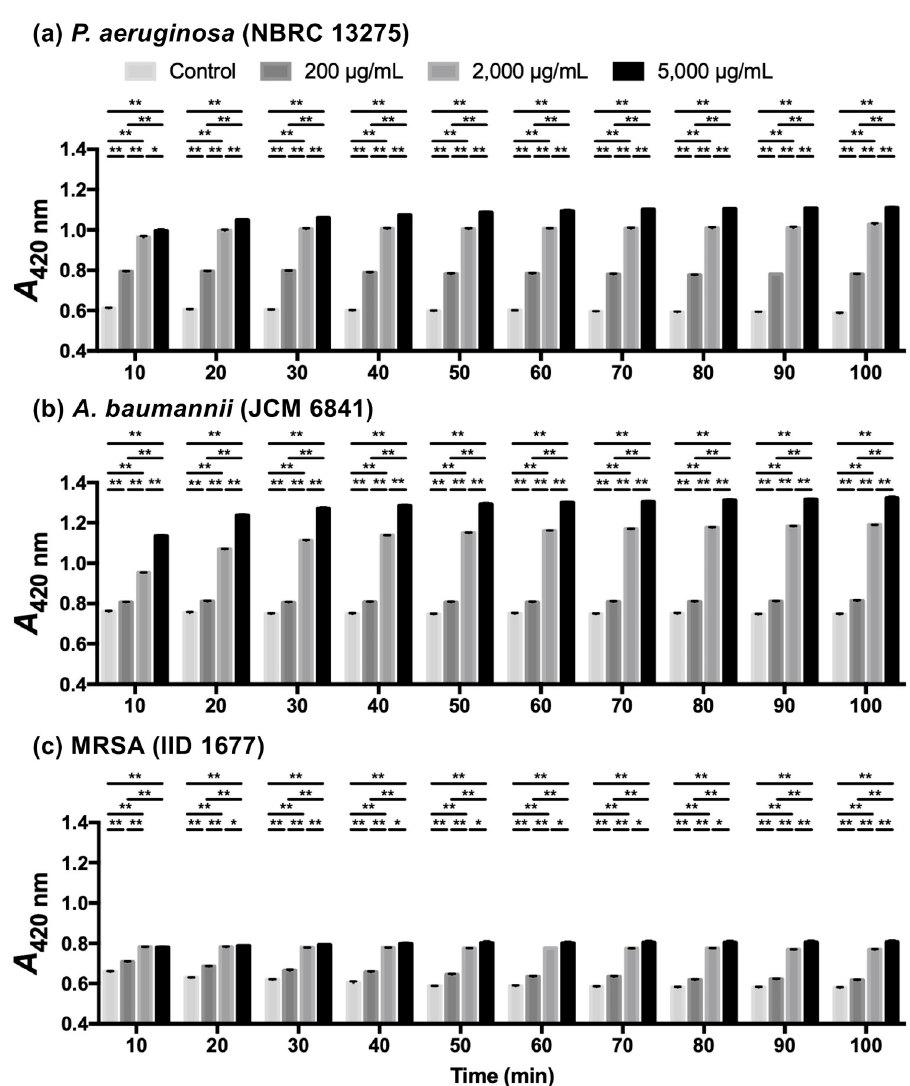
Fig 5. ONPG assays. The measurement of absorbance at 420 nm ( A 420 nm ) can be used to estimate the activity of cytoplasmic β -galactosidase released from bacteria into LYZOX solution using ONPG as the substrate to evaluate inner membrane permeabilization in gram-negative bacteria and plasma membrane permeabilization in gram-positive bacteria. (a) Pseudomonas aeruginosa (NBRC 13275), (b) Acinetobacter baumannii (JCM 6841), (c) MRSA (IID 1677). The values are the mean ± SEM of triplicate measurements. � p < 0.05, �� p < 0.01 (unpaired